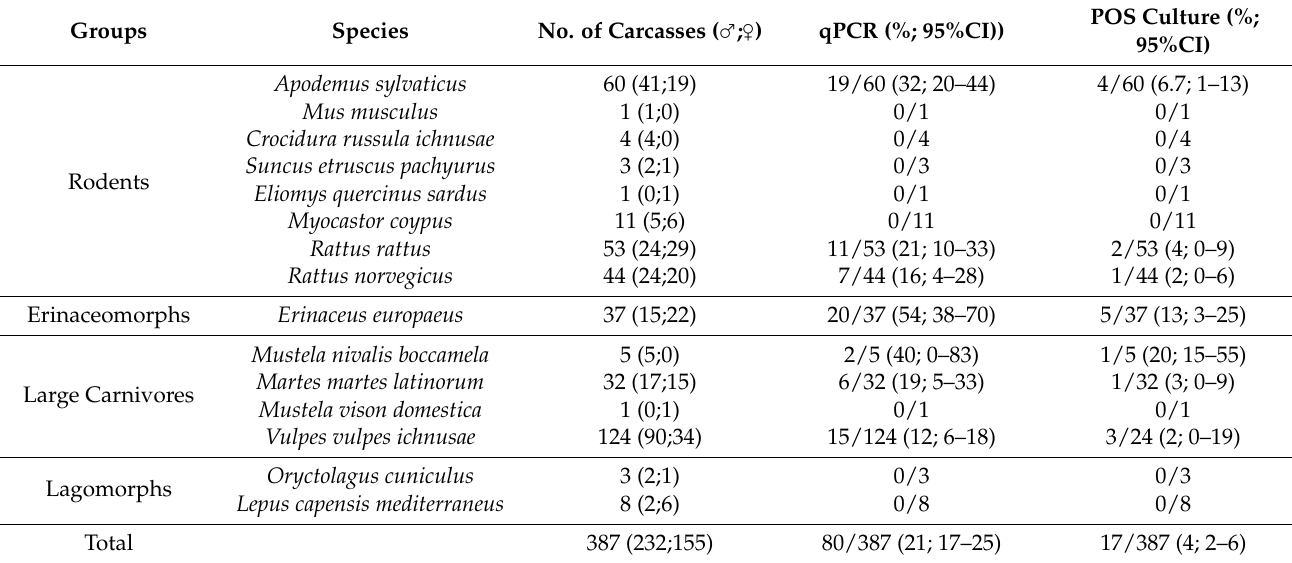
Table 2. Percentages of Leptospira spp. isolated from kidney samples from multiplex qPCR and culture from different host species in